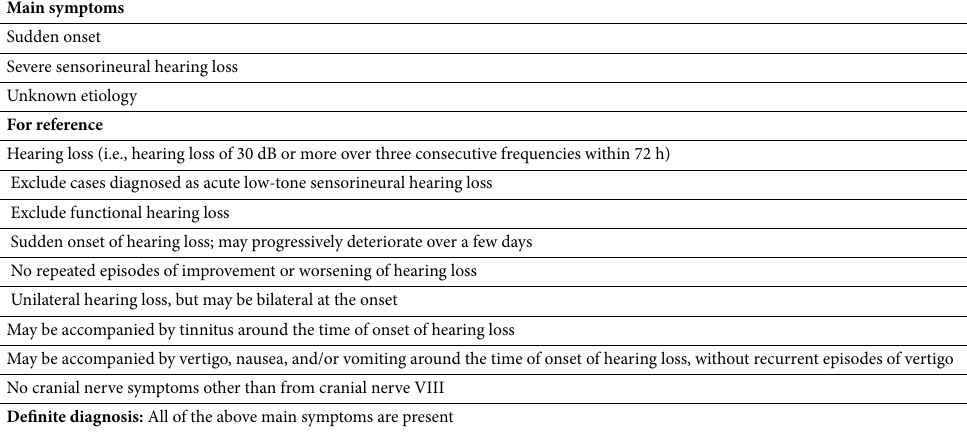
Table 1. Diagnostic Criteria for idiopathic Sudden Sensorineural Hearing Loss (idiopathic SSNHL). *These criteria were established by the Research Committee of the Ministry of Health, Labour, and Welfare of Japan in 2015 14